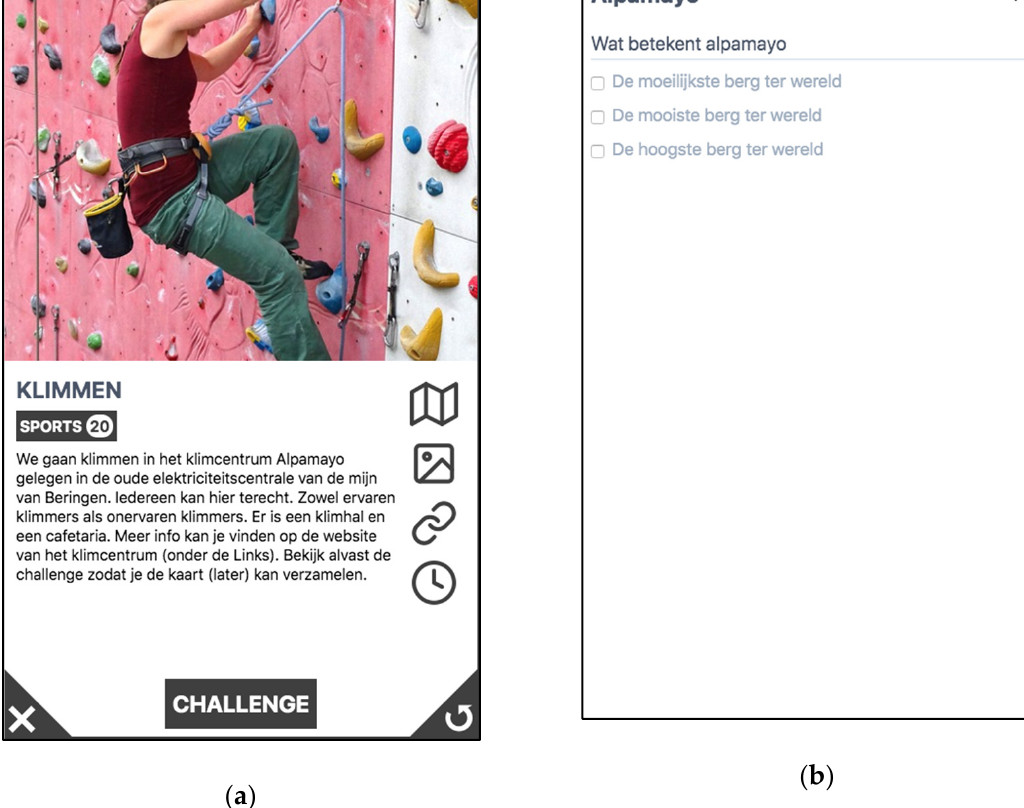
Figure 3. ( a ) An example card (front side); ( b ) An example challenge.